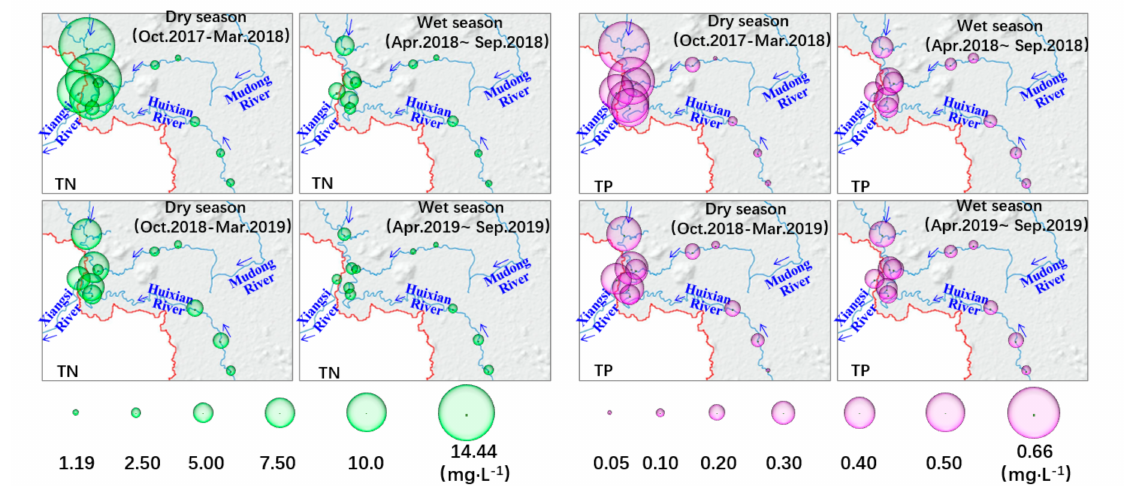
Figure 5. The mean TN and TP concentration at the eleven sampling sites in the dry and wet